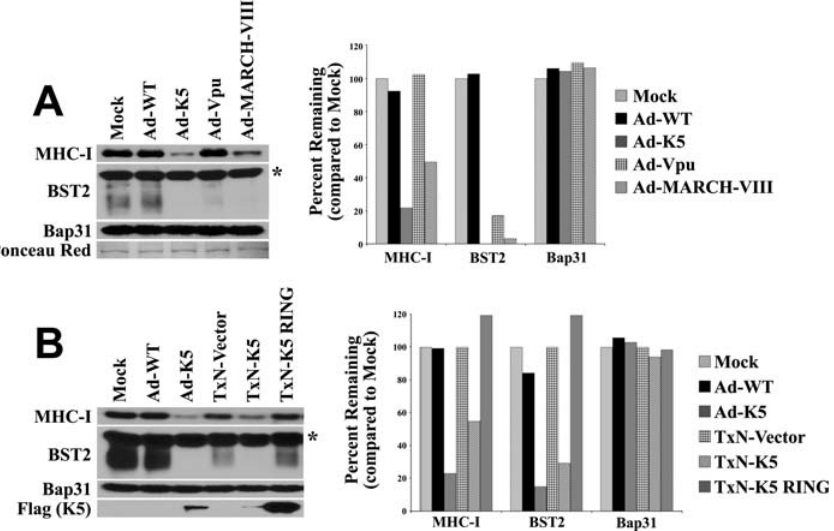
Figure 3. BST-2 Is Differentially Expressed in K5-Expressing Cells HeLa cells were transduced with Ad-WT, Ad-K5, Ad-vpu, or Ad-MARCH-VIII. Then 24 h post-infection, cells were harvested and whole cell lysates were analyzed for the abundance of BST-2 and MHC I by Western blotting. Note that BST-2 is highly glycosylated and runs as multiple bands. The high molecular weight band marked with an asterisk is non-specific. Equal protein loading was confirmed by visualizing the ER resident chaperone Bap31 as well as general protein staining with Ponceau red ([A], left). The intensity of each band was quantified using densitometry ([A], right). The specificity of BST-2 downregulation was confirmed by transfecting K5 or a catalytically inactive K5-RING mutant, which showed no effect on either MHC I or BST-2 (B). The protein bands corresponding to BST-2 are more intense in (B) than in (A) because of longer exposure of the autoradiograph as well as variation in electrophoretic separation. Note that the same lysates were analyzed in lanes 1–3 of the blots in both (A) and (B). DOI: 10.1371/journal.ppat.0020107.g003